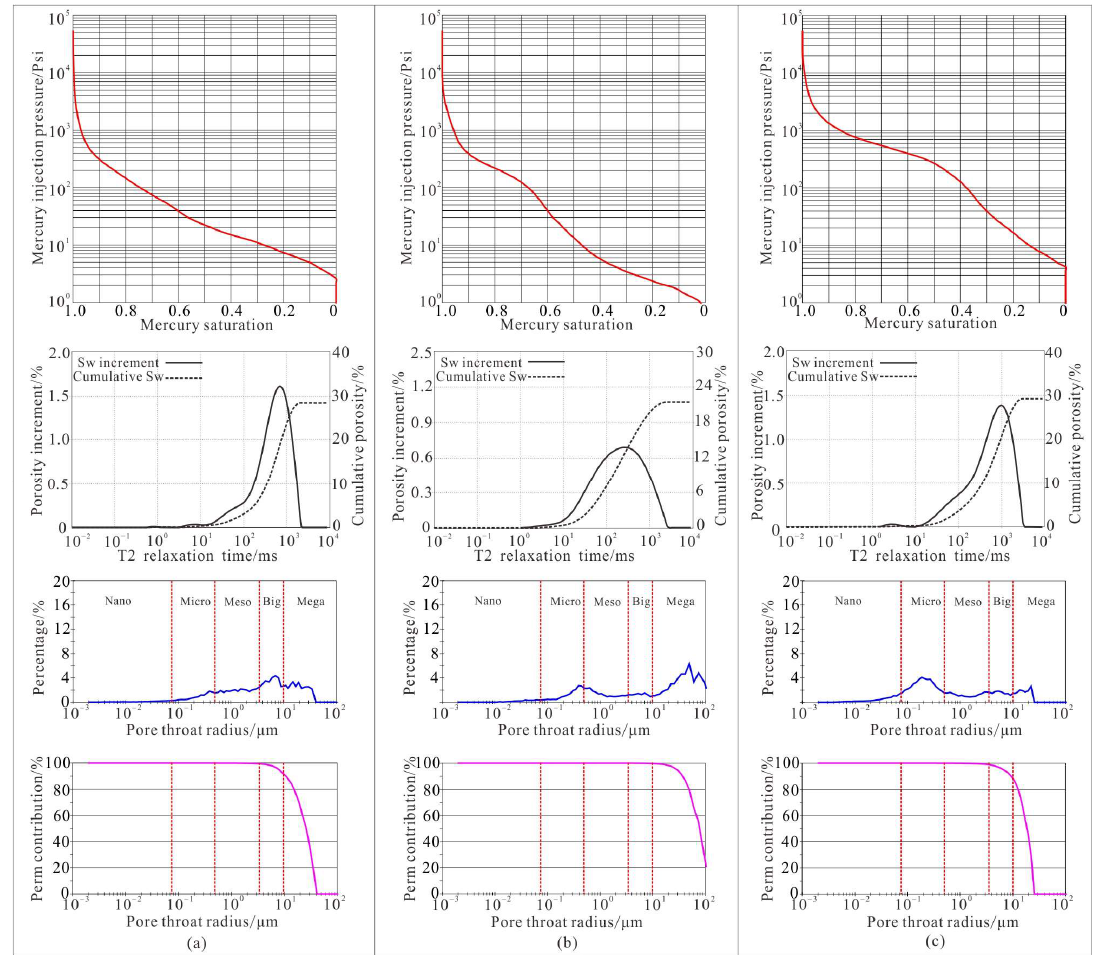
Figure 8. Microstructure characteristics of HFZs in the Mishrif reservoir in X Oilfield. ( a ) Well-240, 2448.7 m, HFZs in the platform marginal shoal; ( b ) Well-239, 2438.03 m, HFZs in the tidal channel; ( c ) Well-114, 2315.65 m, HFZs in the point shoal.